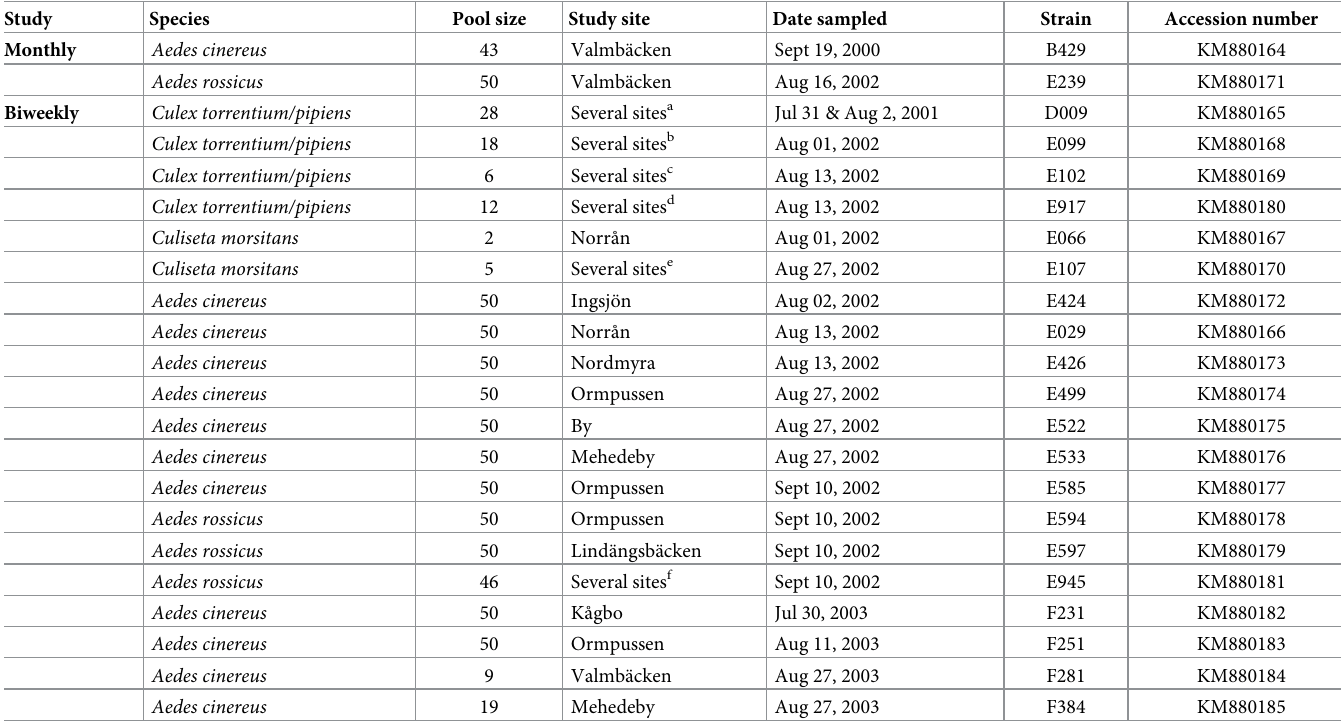
Table 1. Sampling characteristics of the 22 Sindbis virus strains isolated from mosquitoes collected 2000 to 2003 in the River Dala¨lven floodplains, central Sweden. The mosquitoes were collected in two separate studies; monthly sampling at six study sites in 2000–2002 for a mosquito diversity study [28], and biweekly sampling in 23–26 study sites in 2001–2003 as part of the BMC mosquito surveillance program